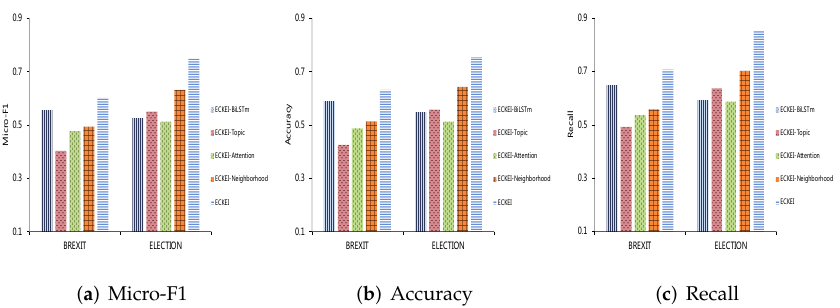
Figure 11. Micro-F1, accuracy and recall ablation results on two datasets for the neutral stance.